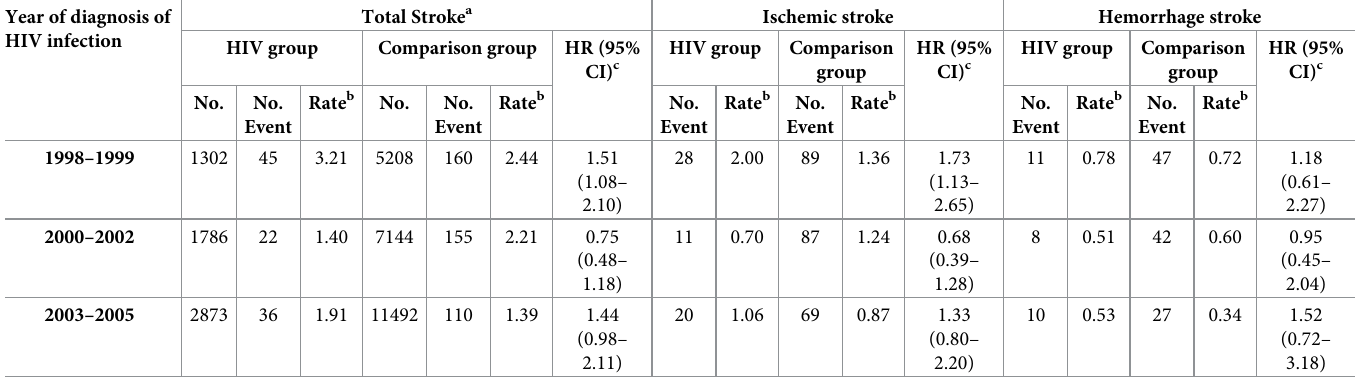
Table 3. Risk of stroke in patients with HIV infection according to calendar year of diagnosis. Year of diagnosis of HIV infection